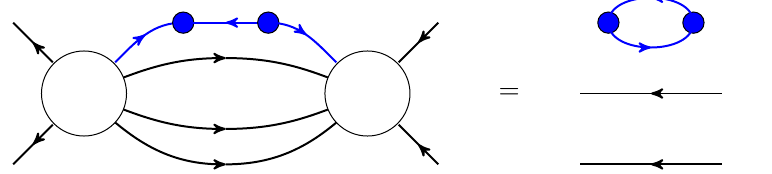
Figure 13. The identity used to show the cut γ 1 in figure 11a is isometric up to a normalization